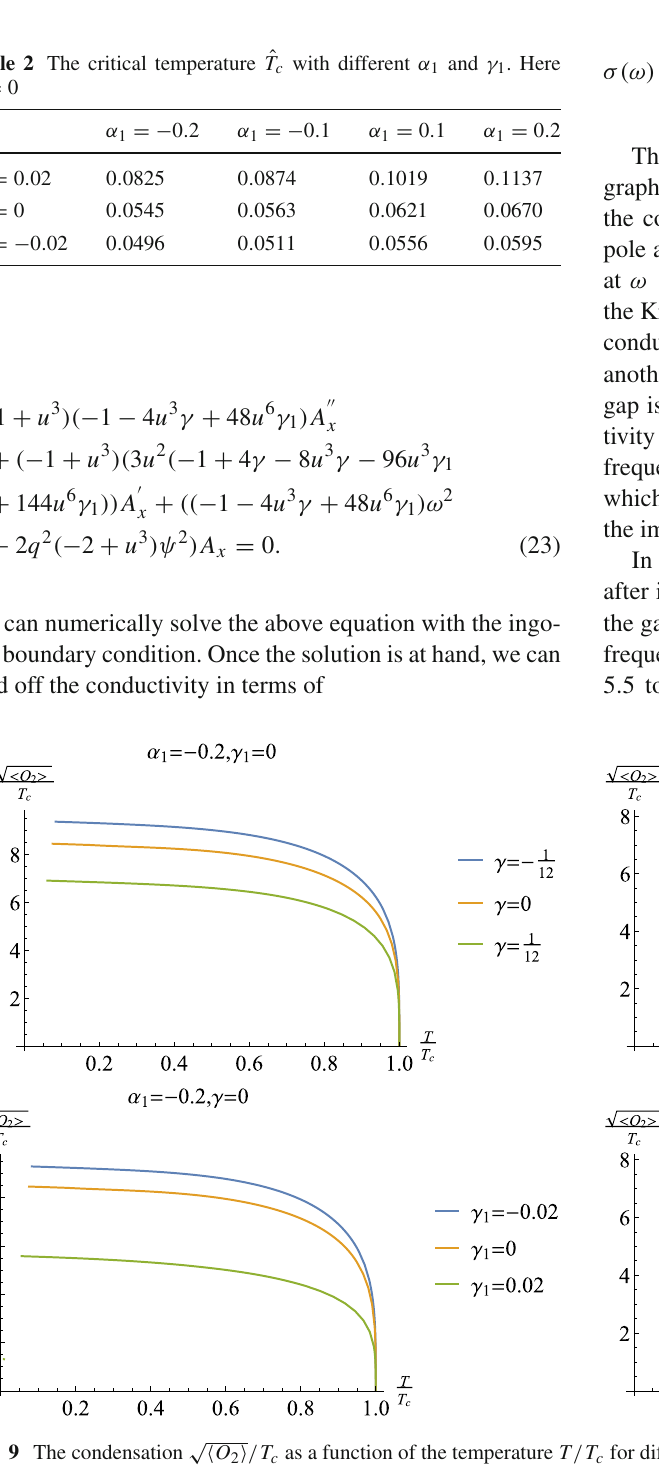
Fig. 9 The condensation